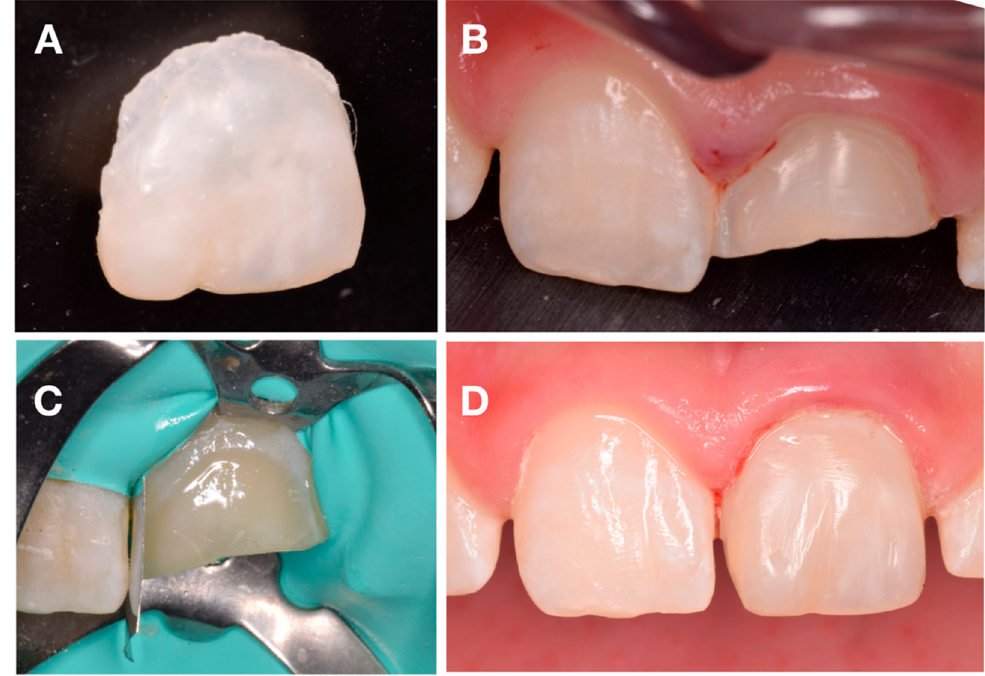
Figure 4. Intra-oral photography. ( A ) Composite veneer. ( B ) Veneer prep. ( C ) Rubber dam isolation. ( D ) Composite veneer immediately after cementation.